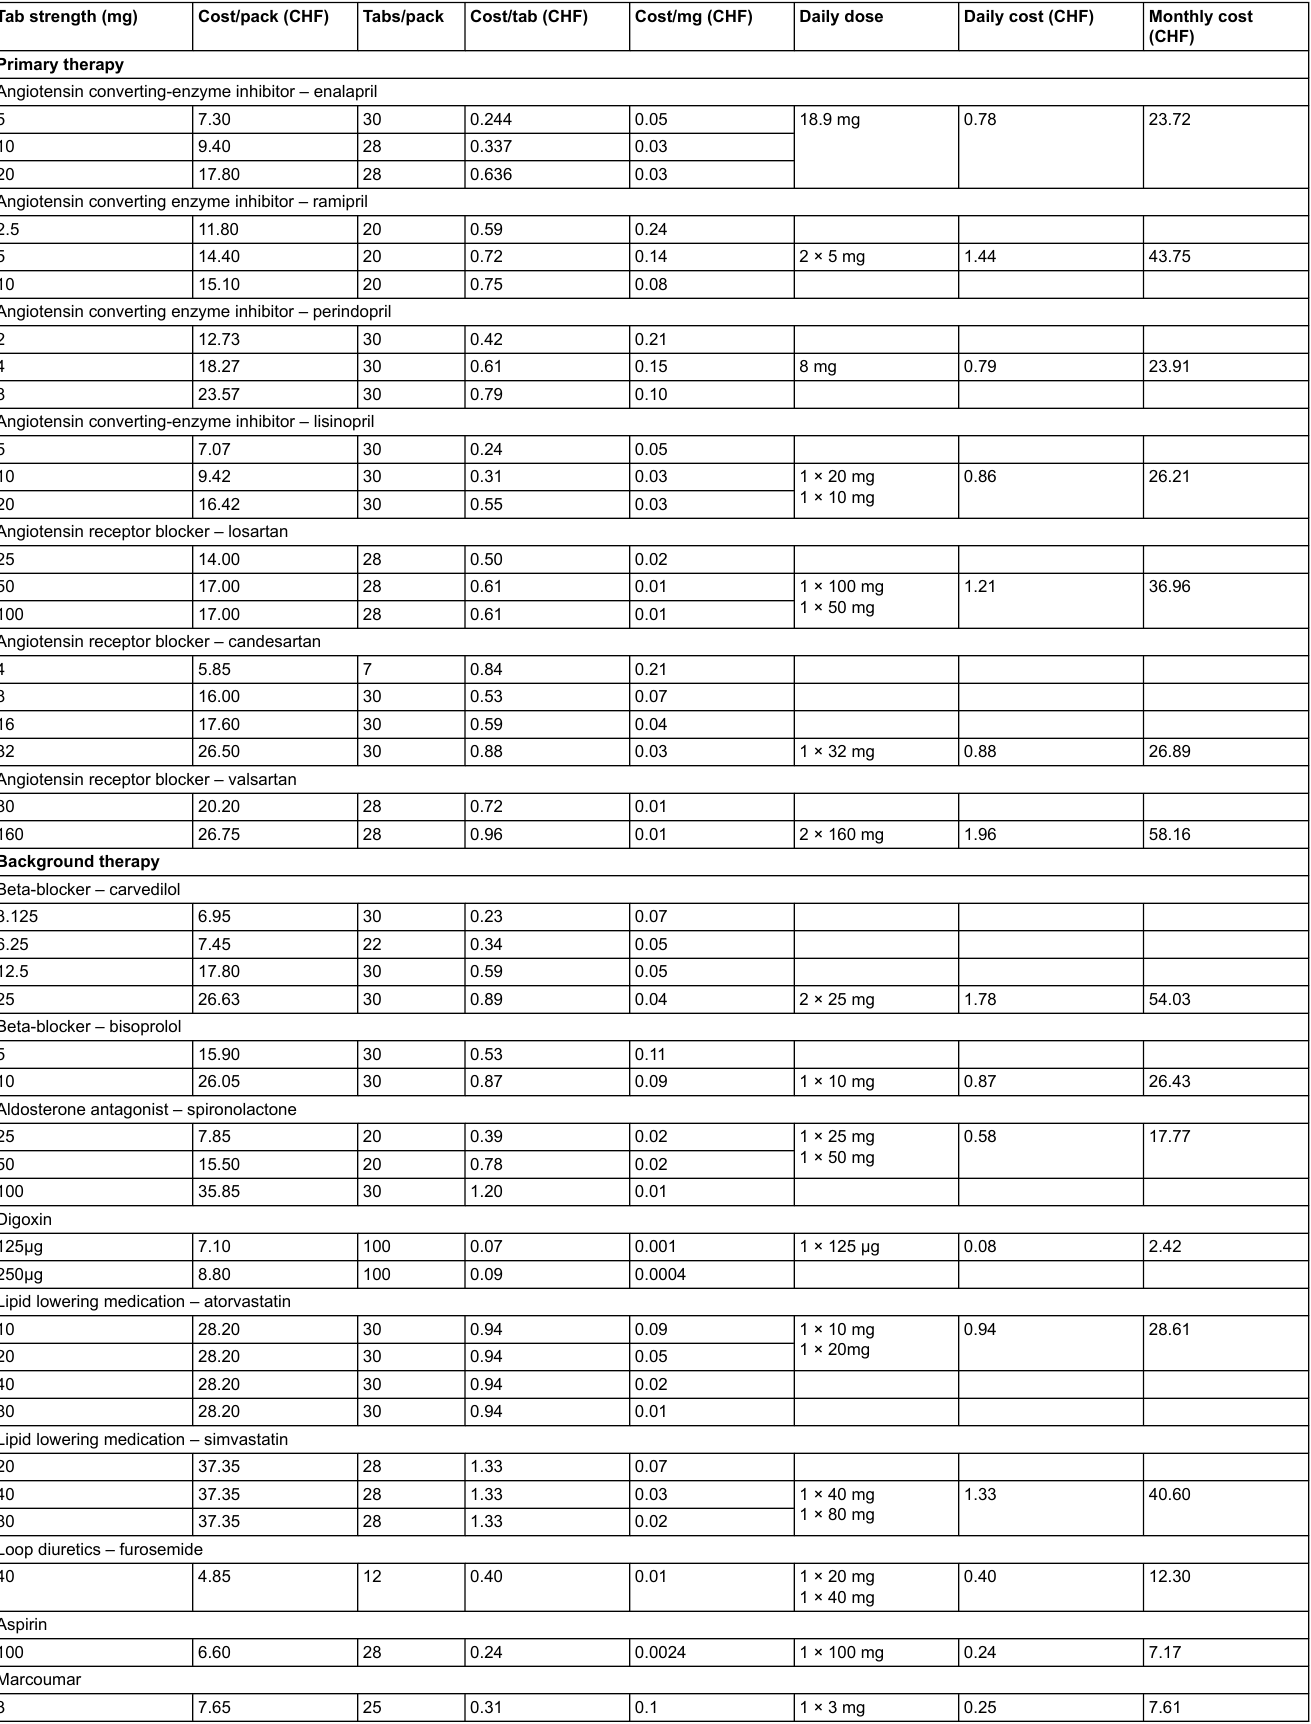
Table S10: Swiss drug costs of primary and background therapy for heart failure. Tab strength (mg) Cost/pack (CHF) Monthly cost